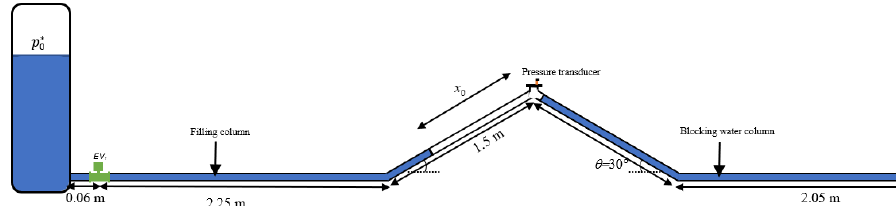
Figure 8. Experimental facility. Table 2. Experimental